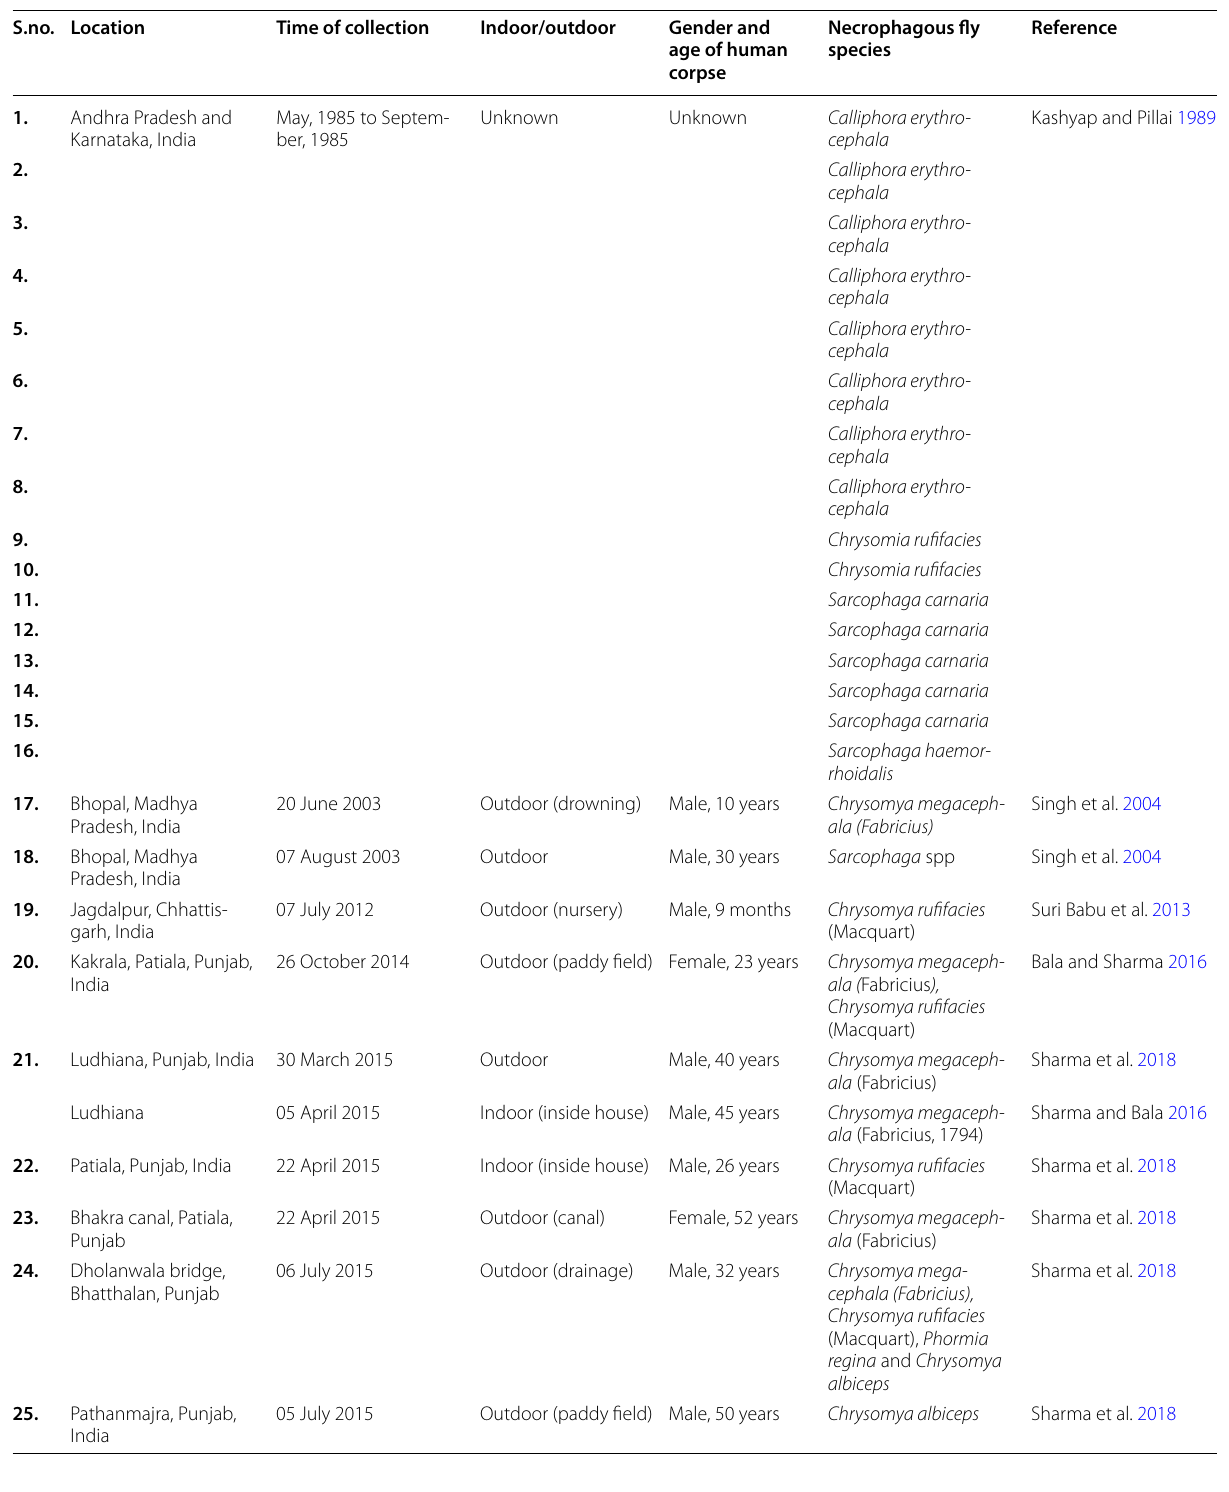
Table 3 Historical distribution of necrophagous fly species colonizing human corpses in India as per the published reports between 1985 and 2018 S.no.